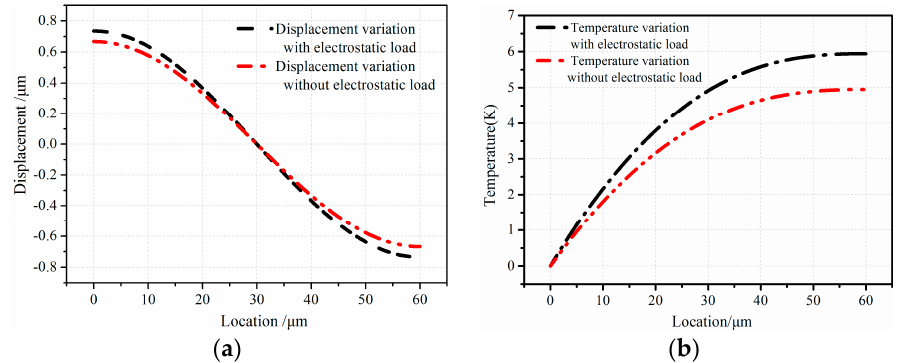
Figure 5. Field quantities variation under different conditions: ( a ) displacement variation with and without electrostatic load; ( b ) temperature variation with and without electrostatic load.